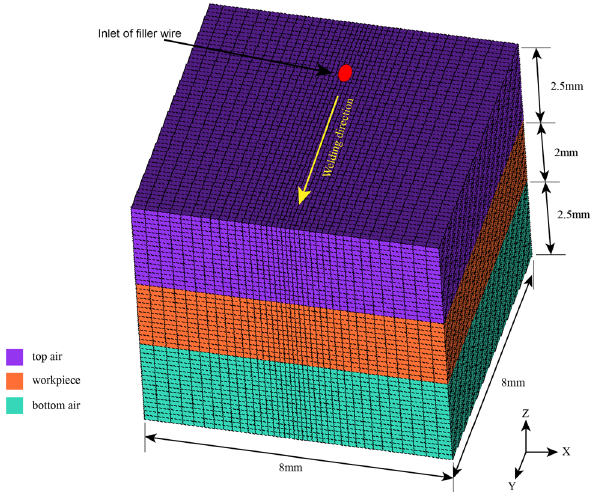
Figure 3: Diagram of the computational